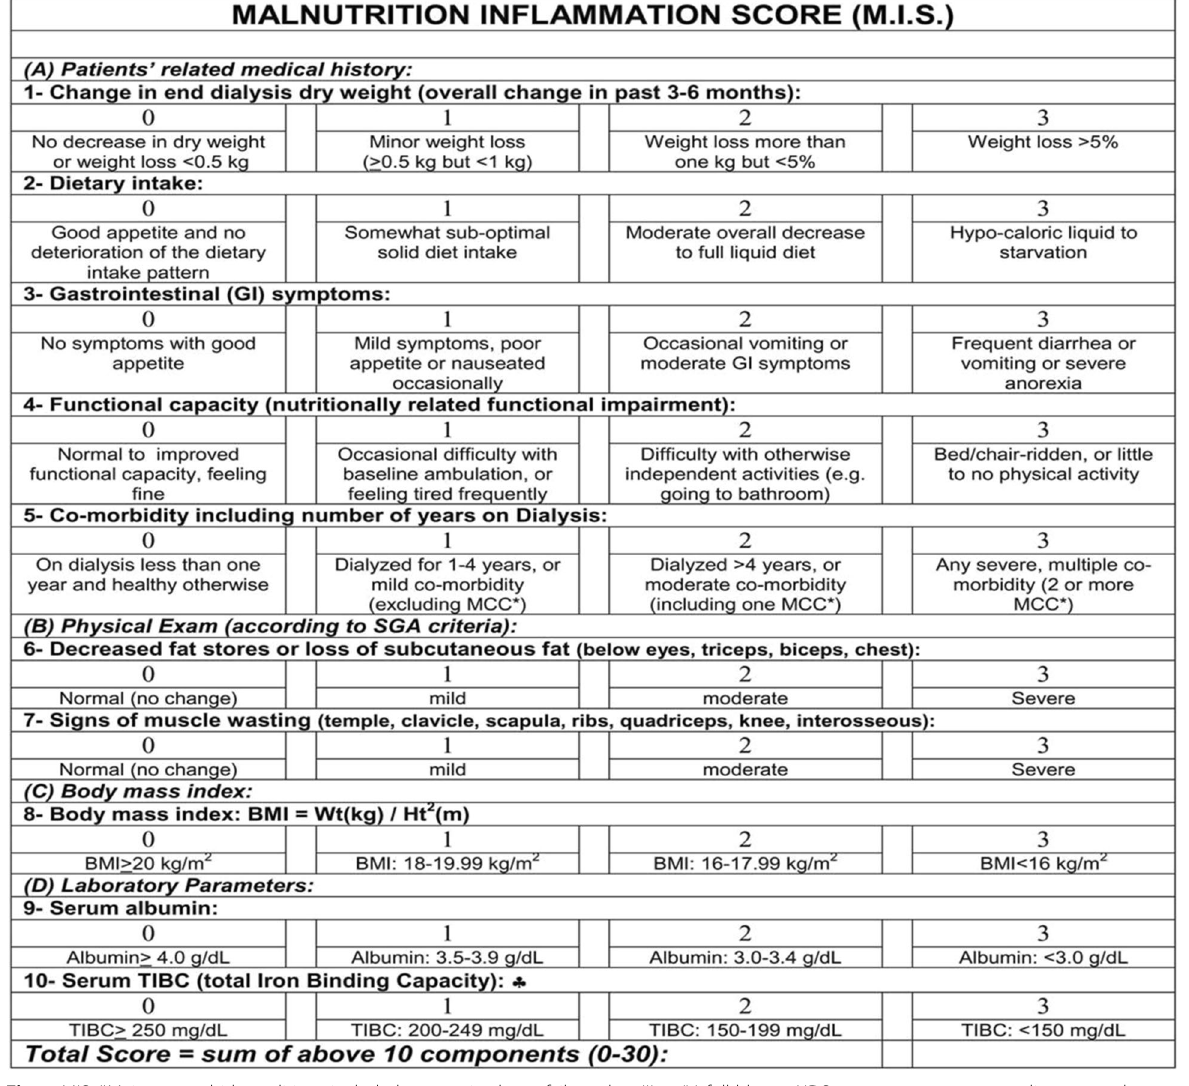
Fig. 1 MIS. *Major comorbid conditions included congestive heart failure class III or IV, full-blown AIDS, severe coronary artery disease, moderate to severe chronic obstructive pulmonary disease, major neurologic sequelae, and metastatic malignancies or recent chemotherapy Suggested equivalent increments for serum transferrin are > 200 (0), 170 to 200 (1), 140 to 170 (2), and <140 mg/dL